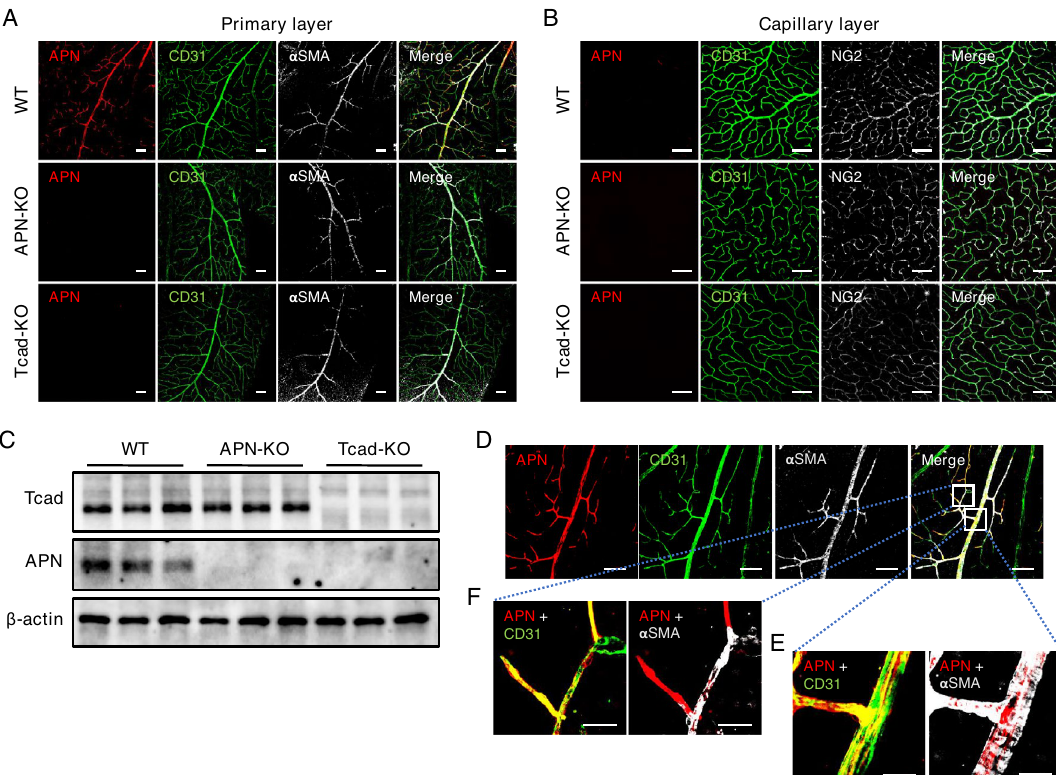
Figure 1. Localization of adiponectin in the mouse retina. ( A , B ) Representative images of retinal whole-mount immunofluorescence staining of male wild-type (WT), adiponectin knockout (APN-KO), and T-cadherin knockout (Tcad-KO) mice. ( A ) Triple immunostaining for APN (red), CD31 (green), and αSMA (gray) in the primary layer. Scale bar = 100 μm. ( B ) Triple immunostaining for APN (red), CD31 (green), and NG2 (gray) in the capillary layer. Scale bar = 100 μm. ( C ) Immunoblots for APN, Tcad, and β-actin proteins extracted from whole retinas of WT, APN-KO, and Tcad-KO mice. Original blots/gels are presented in Supple. Fig. 1. ( D ) Representative images of triple immunostaining for APN (red), CD31 (green), and αSMA (gray) of retinas from WT mice. Scale bar = 100 μm. ( E , F ) High magnification images of the arteriole ( E ) and the transitional zone between the arteriole and the capillary ( F ). Scale bar = 25